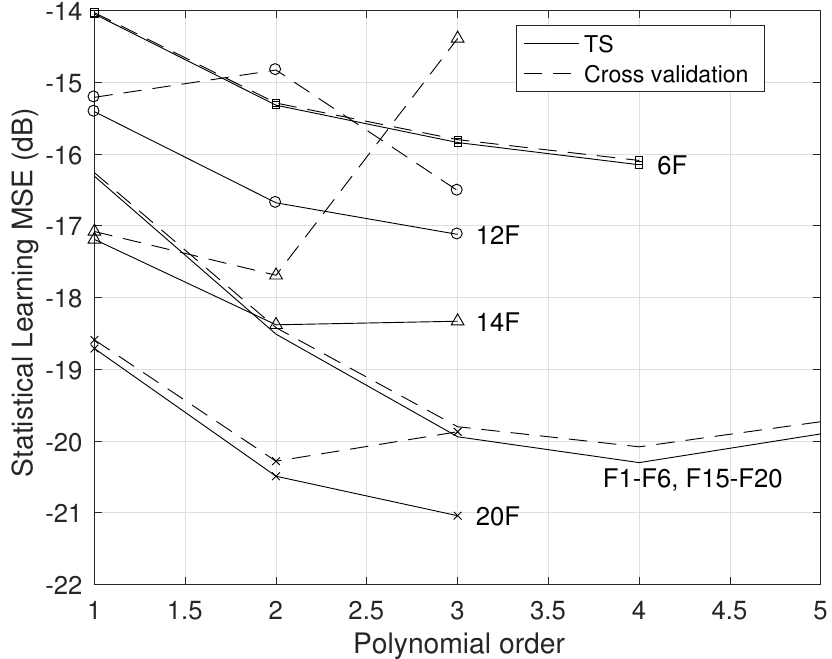
Figure 9. MSE versus the polynomial order in statistical learning for the different feature combinations of “6F” (F1–F6), “12F” (F1–F12), “14F” (F1–F14), and “20F”